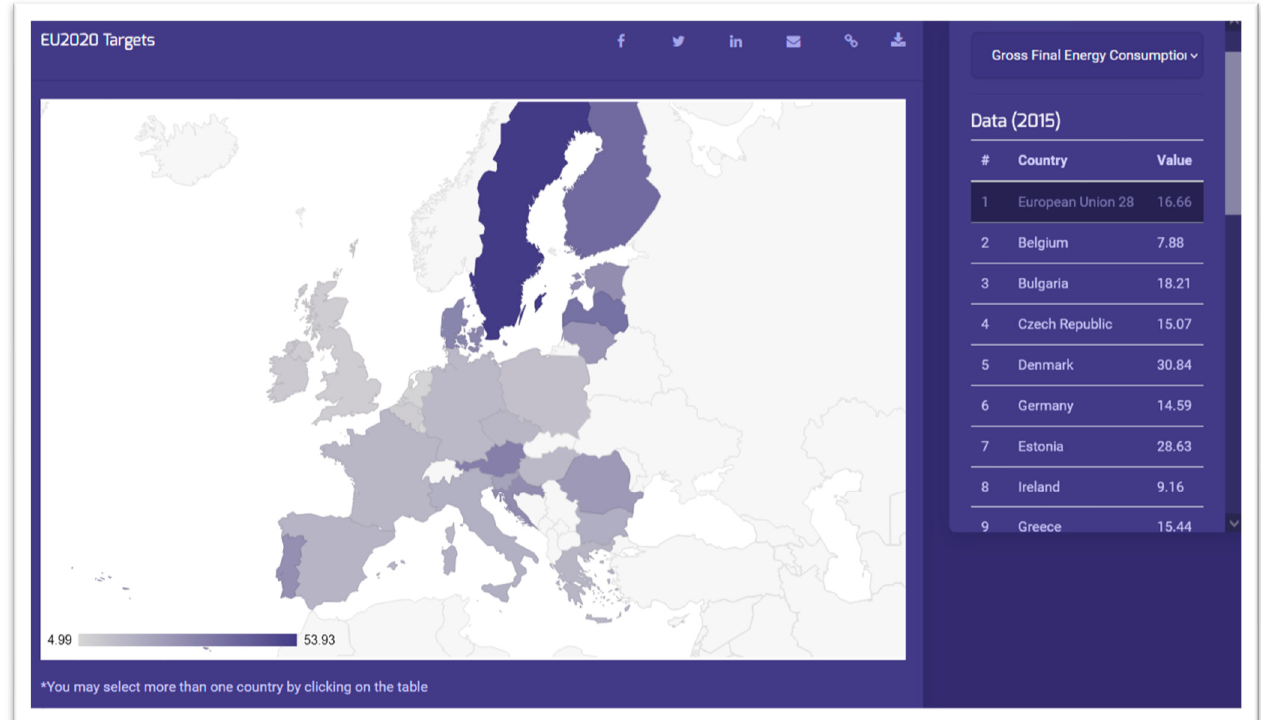
Figure 3. EU heat map of Gross Final Energy Consumption. The bar chart shows the value in 2015, the predicted value, and the target of the selected indicator for a selected EU country (Figure 4).